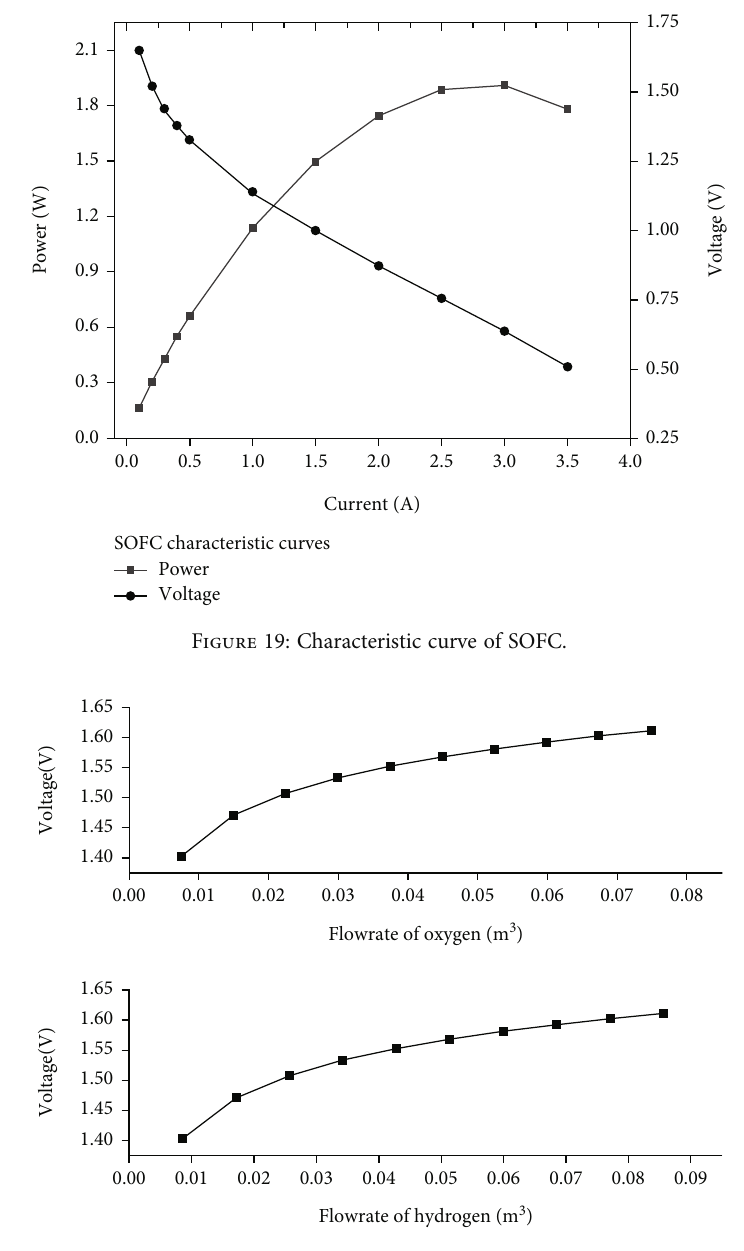
Figure 20: Flow rate e ff ect of SOFC